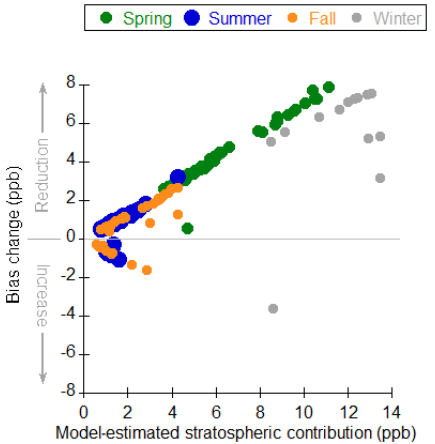
Figure 11. Impact of dynamic-PV scaling parameterization on model performance for surface-level seasonal mean maximum daily 8h average O 3 (MD8O 3 ) at CASTNET sites in the United States. The model-estimated stratospheric contribution is estimated as the difference between the simulation with the dynamic-PV scaling and one without. The bias change is estimated as the difference between the absolute bias in the simulation with a constant-PV (20PV) scal- ing and the absolute bias in the dynamic-PV scaling simulations. Positive changes in bias represent reduction in bias due to dynamic PV, while negative changes represent an increase in bias in sim- ulated surface MD8O 3 . Seasonal means are computed based on model-observed pairs when the observed MD8O 3 >